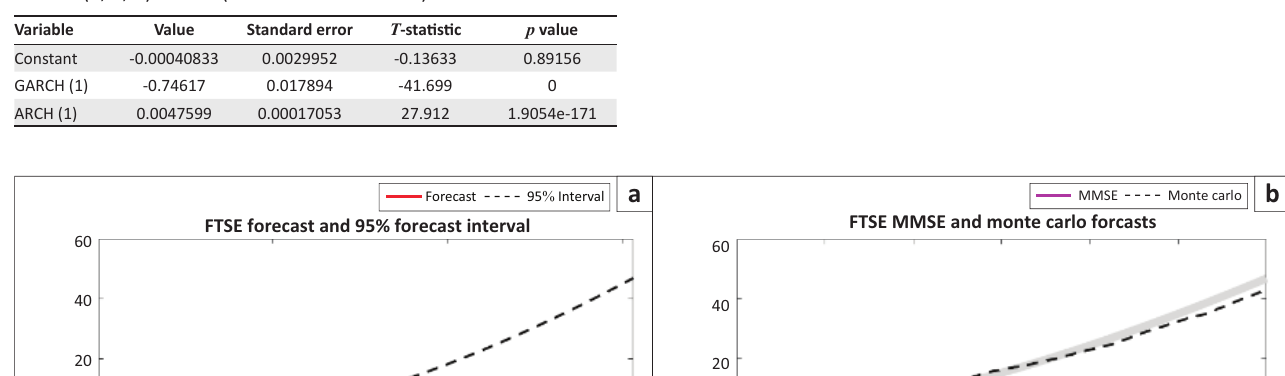
3. Modelling the Financial Times Stock Exchange/Johannesburg Stock Exchange estimating autoregressive integrated moving average and generalised autoregressive conditional heteroscedasticity for the best possible fit of the respective models. ARIMA (1, 2, 0) Model (Gaussian distribution):